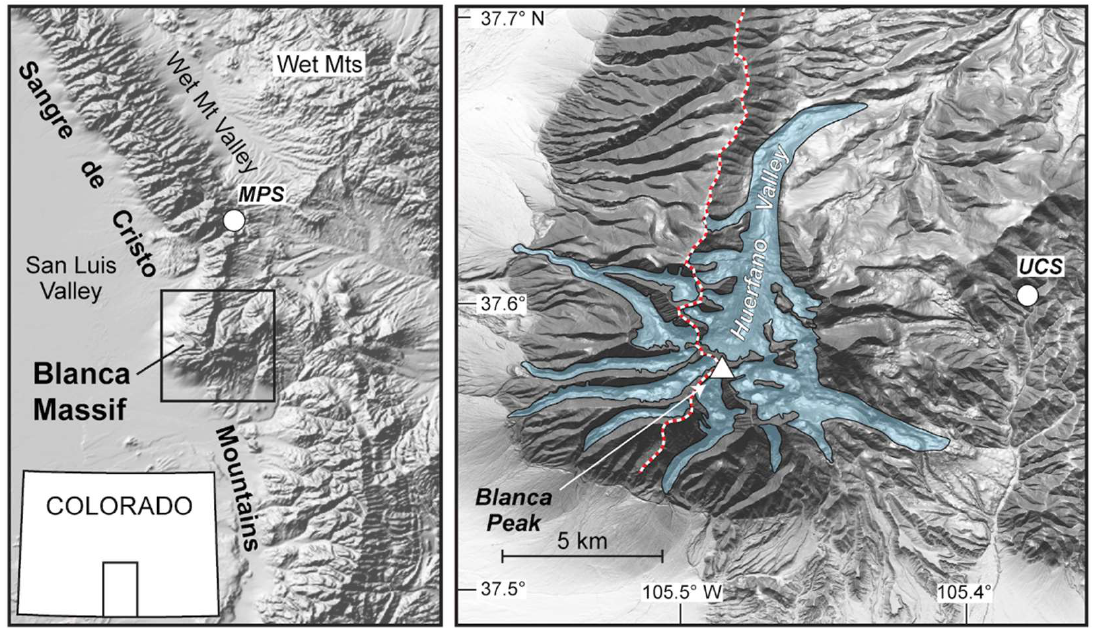
Figure 1. Location map of the Blanca Massif within the Sangre de Cristo Mountains in Colorado. MPS and UCS are the locations of the Medano Pass and Ute Creek SNOTEL sites, respectively. Outlines of the glaciers studied are shown schematically—see Figure 4 for details. The red and white dashed line delineates the range crest in the north and defines the eastern and western sides of the massif as defined in this study.